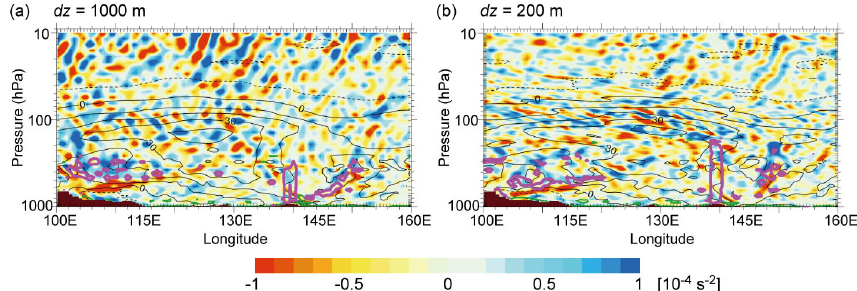
Figure 3. Instantaneous longitude–height distribution of the unfiltered divergence component of the horizontal winds (color), the low-pass filtered ( > 1000km) eastward winds (black contours with an interval of 15ms − 1 ) and the moist diabatic heating rate of 0.1Kh − 1 (purple contours) at 37.5 ◦ N, 00:00UT, 24 June. Green lines show regions of R i < 0 . 25, where parameterized turbulent mixing occurs in the model. Note that the longitudinal coverage is different from Fig. 2.